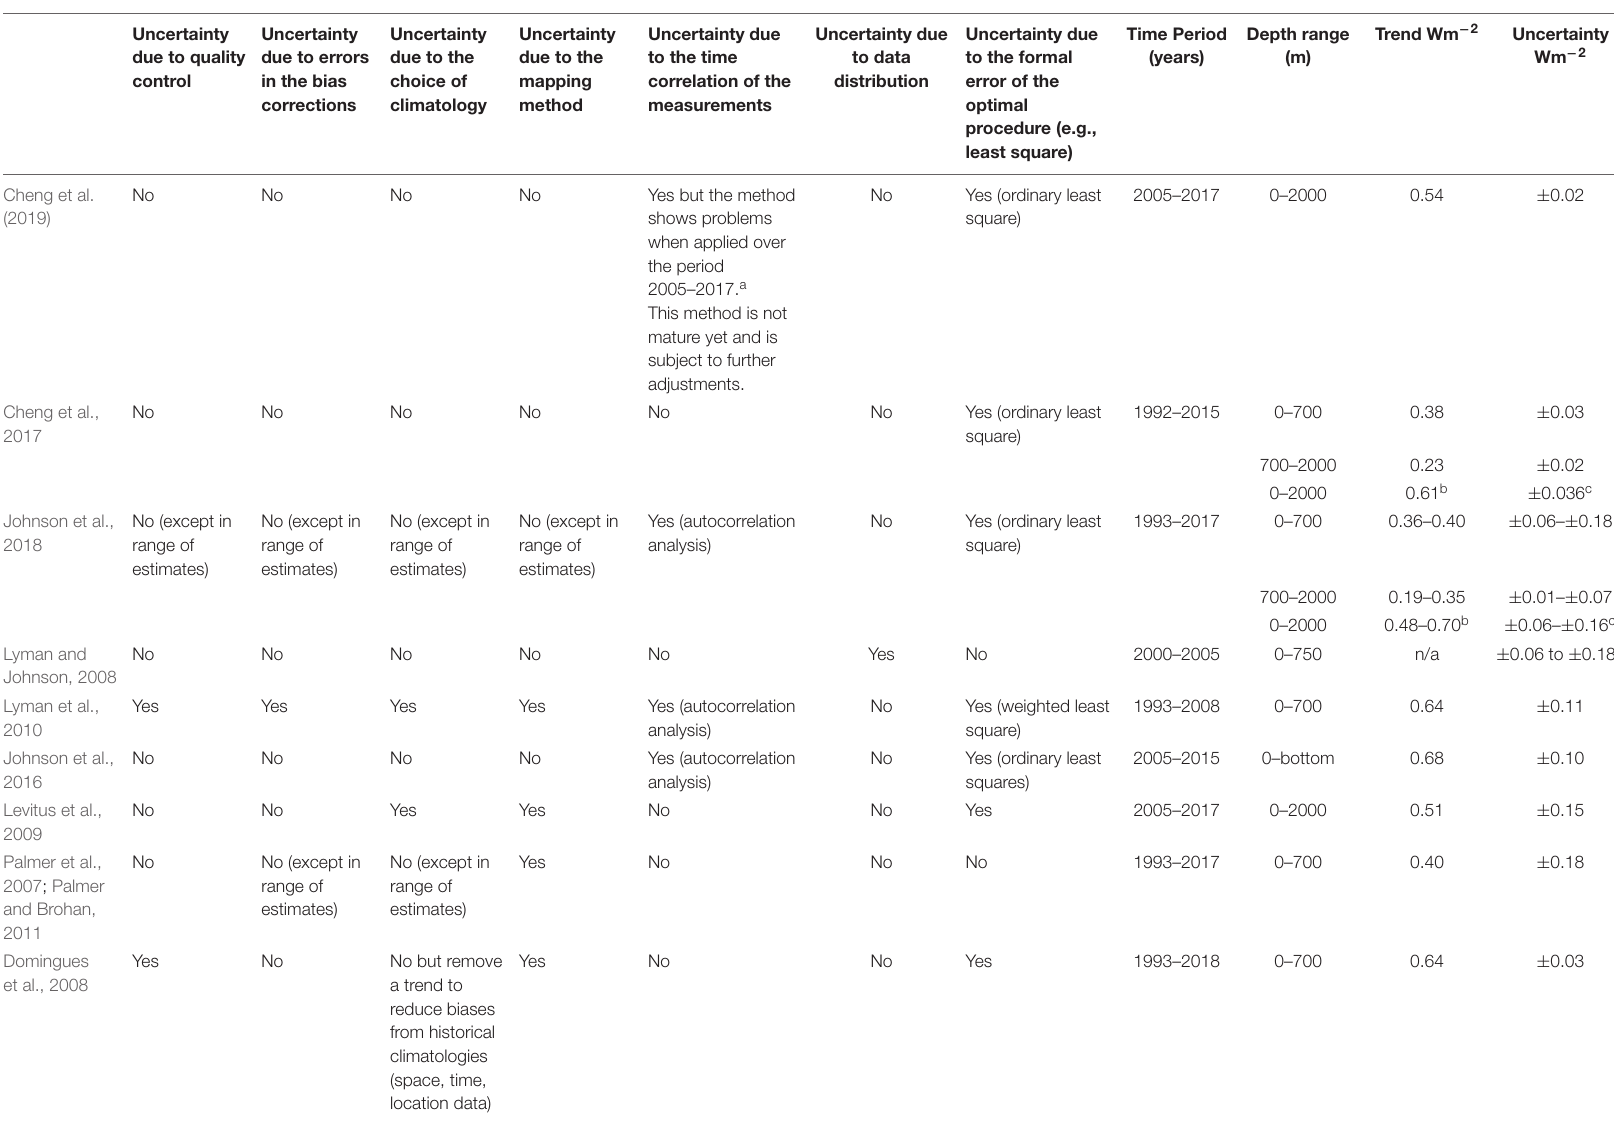
TABLE 1 | Ocean heat content change in Wm − 2 and associated uncertainties from recent studies based on in situ data. Column 2–8 indicate the different sources of uncertainty accounted for. Column 9 indicates the period of computation. Column 10 indicates the region that is